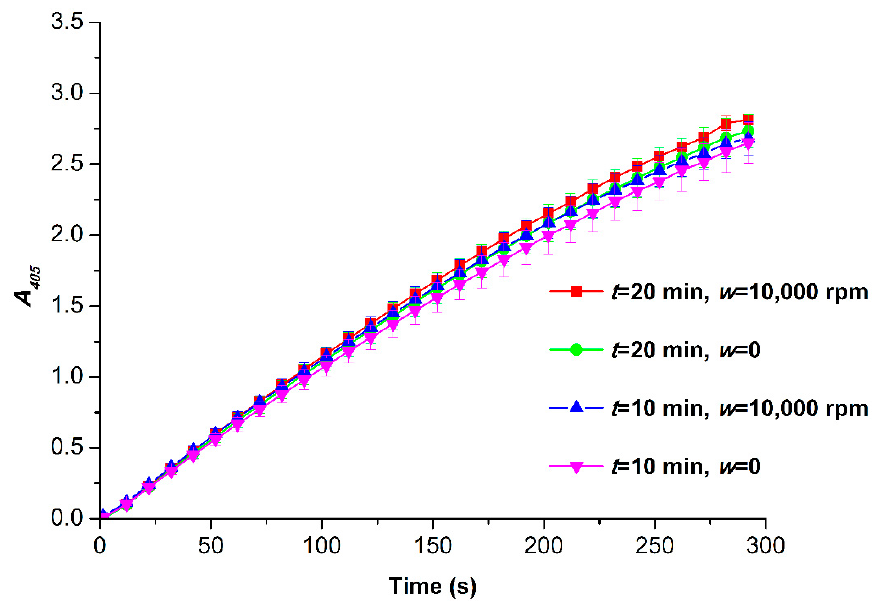
Figure 4. A 405 ( t ) kinetic curves obtained using the HRP-ABTS-H 2 O 2 system for HRP samples incubated at w = 0 (non-rotating cone), t = 10 min (control) (magenta); w = 10,000 rpm (rotating cone), t = 10 min (working experiment) (blue); w = 0 (non-rotating cone), t = 20 min (control) (green); w = 10,000 rpm (rotating cone), t = 20 min (working experiment) (red). Measurement conditions: HRP:ABTS:H 2 O 2 = 1 nM:2.5 mM:0.3 mM; pH 5.0; cell pathlength 1 cm, temperature 25 °C.